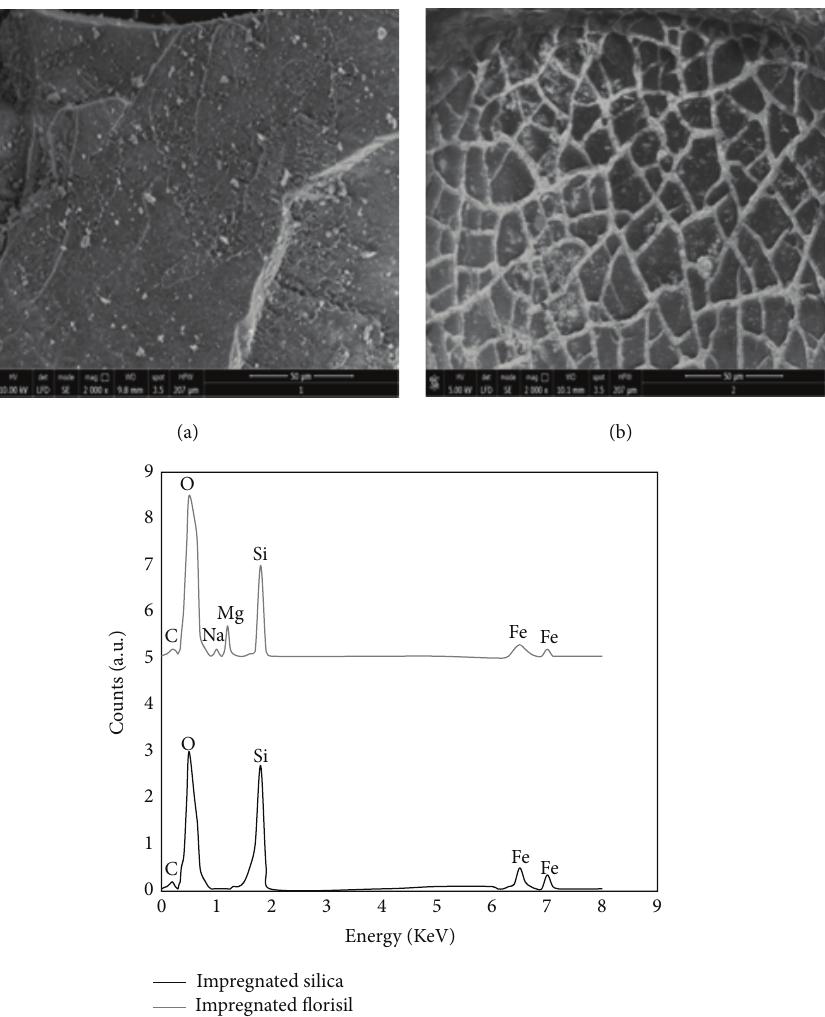
Figure 3: SEM images and EDX spectrum of impregnated florisil (a) and impregnated silica